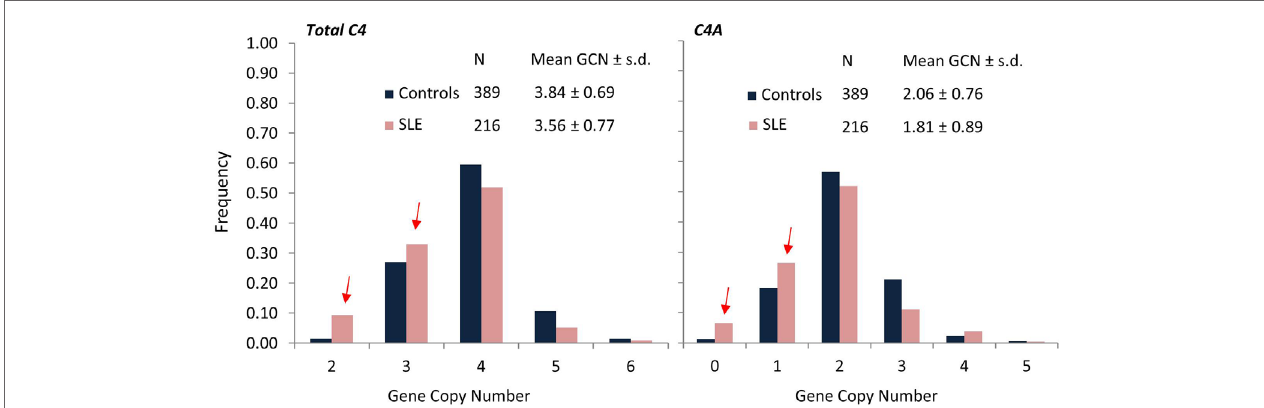
FiGURe 5 | Comparisons of frequencies for total C4, C4A, and C4B gene copy-number groups in SLe (red) and controls (blue) . SLE patients ( N = 216) of European ancestry showed significantly higher frequencies for lower copy-numbers of total C4 (GCN = 2 or 3) and C4A (GCN = 0 or 1) compared to healthy, race-matched controls ( N = 389). Mean GCN for Total C4 in SLE (3.56 ± 0.77) was significantly lower than in controls (3.84 ± 0.69; p = 5.3 × 10 − 6 , t -test). Similarly, mean GCN for C4A in SLE (1.81 ± 0.89) was significantly lower than in controls (2.06 ± 0.76; p = 2.0 × 10 − 4 , t -test) [modified from Ref.